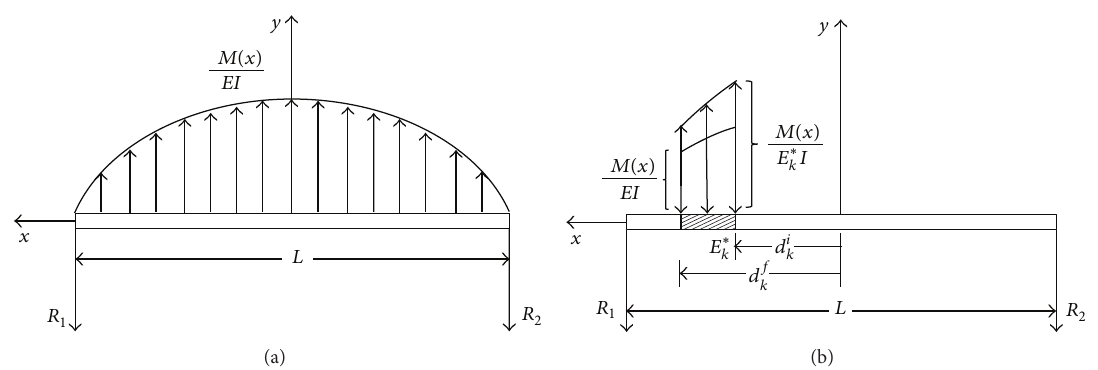
Figure 2: Schematic showing (a) conjugate beam loading for the real beam with no local reduction in modulus and (b) additional conjugate loading due to 𝐸 ∗ 𝑘